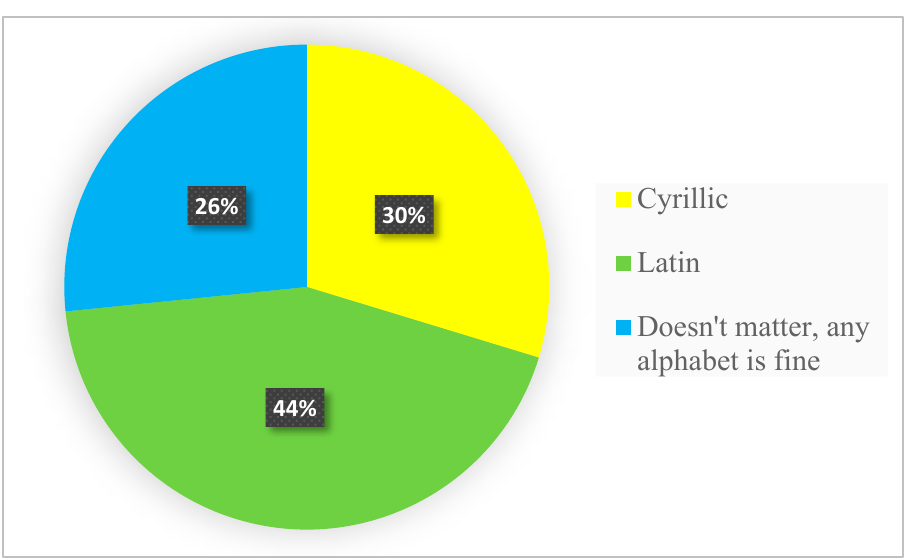
Figure 3. The most suitable alphabet for use in Internet communication.